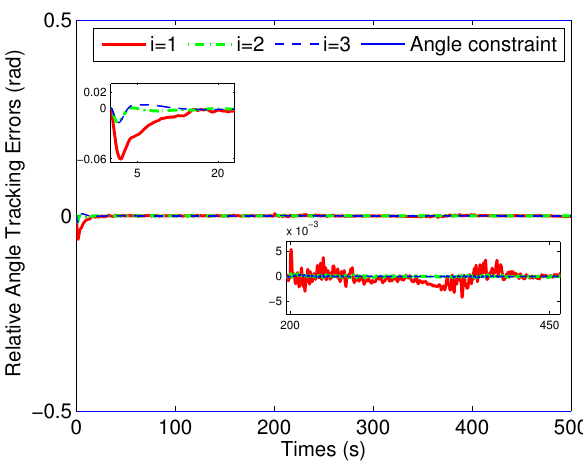
Figure 15. Yaw angle tracking errors under 1 m